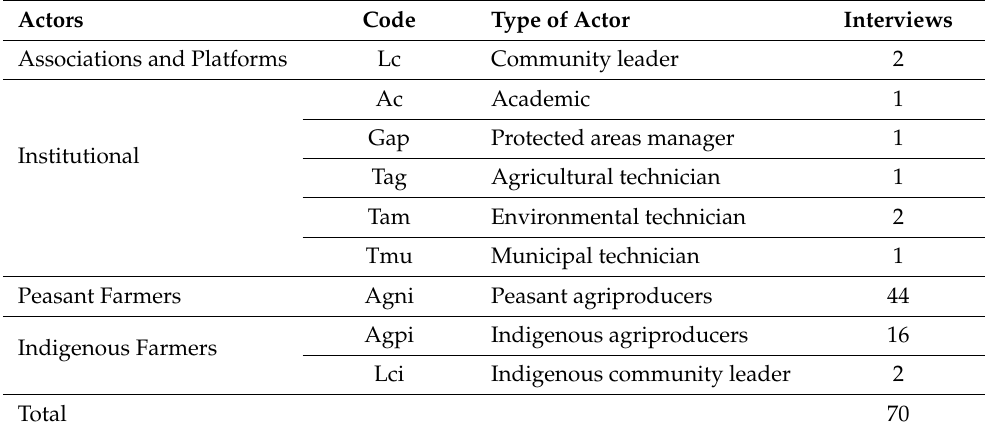
Table 2. Type of actors interviewed.